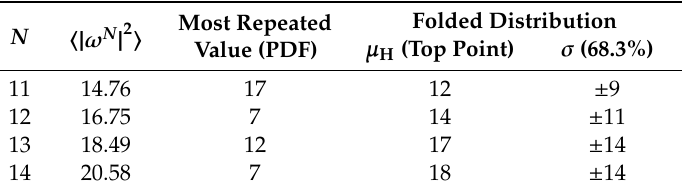
Table A16. Statistical parameters of SAW size for the BCC restricted lattice as a function of SAW steps (fixed: n = 5, Type 3) for selected systems.